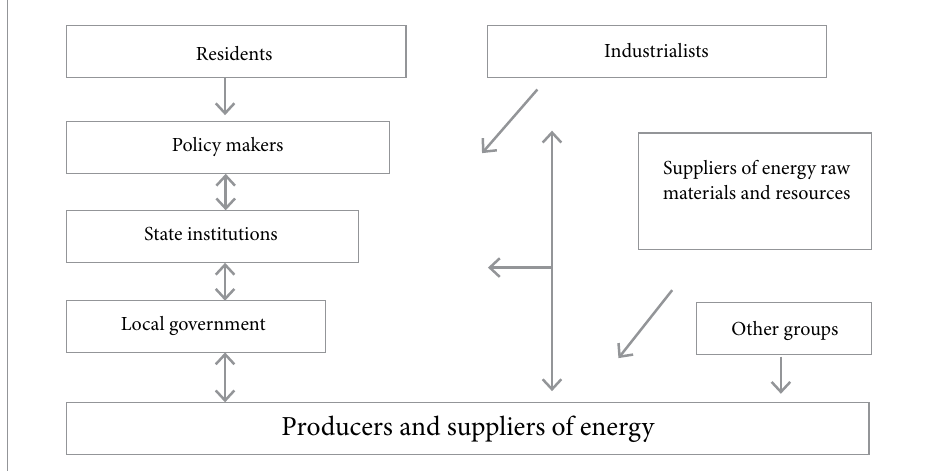
Fig. 2. Interrelations between stakeholder groups and the analysed